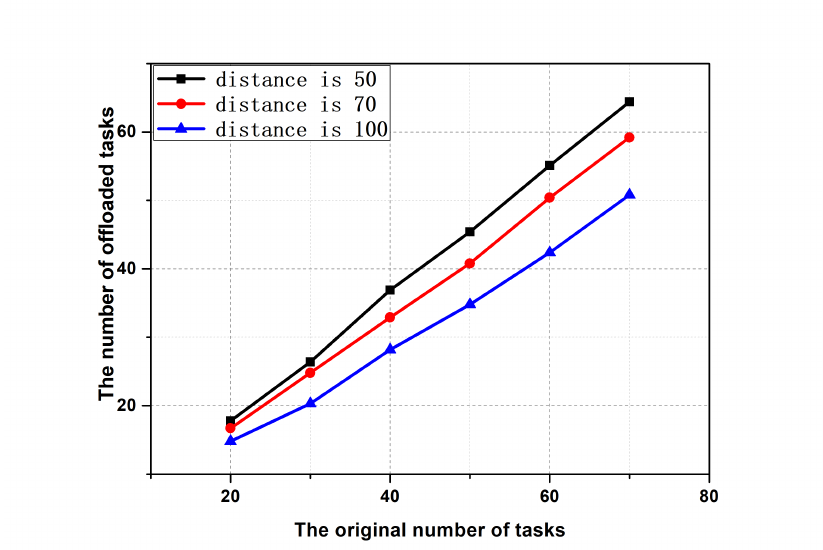
Figure 3. The offloading performance under different